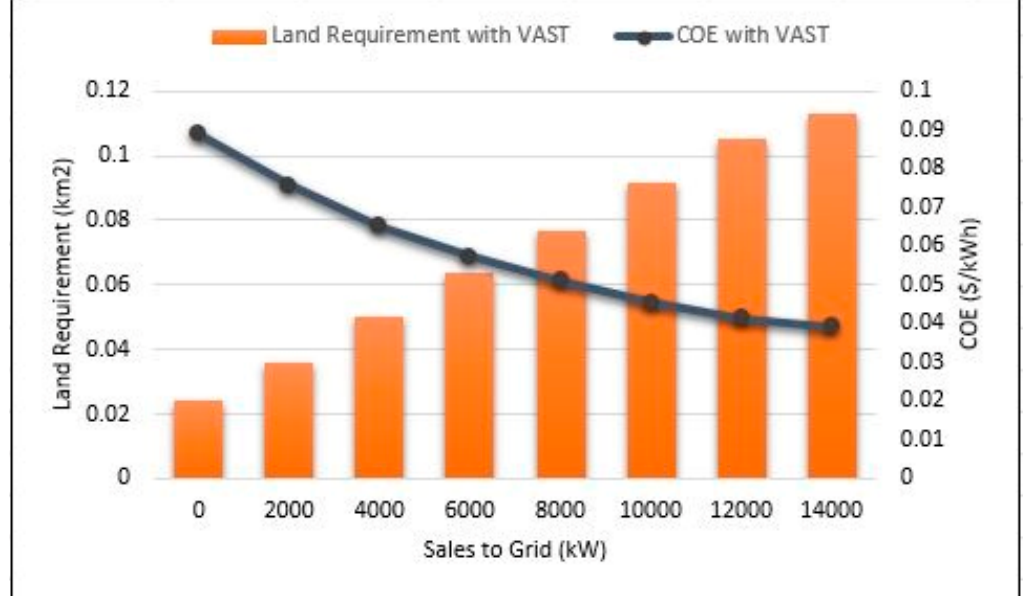
Figure 11. Land requirement and LCOE change of the system using vertical solar tracker with different sales capacity .